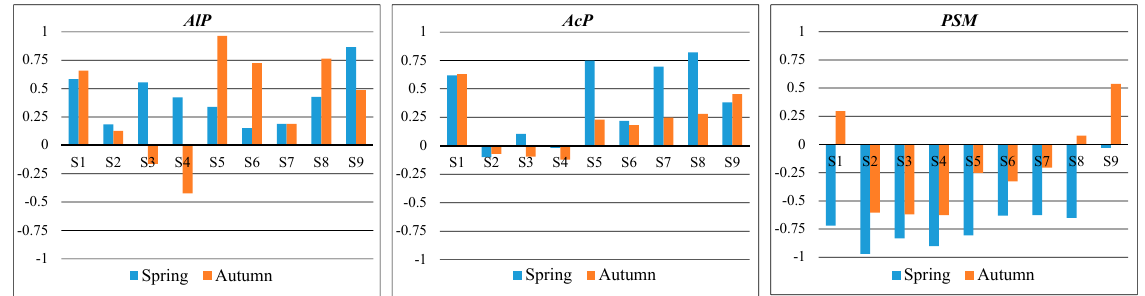
human impact was smallest in these places.